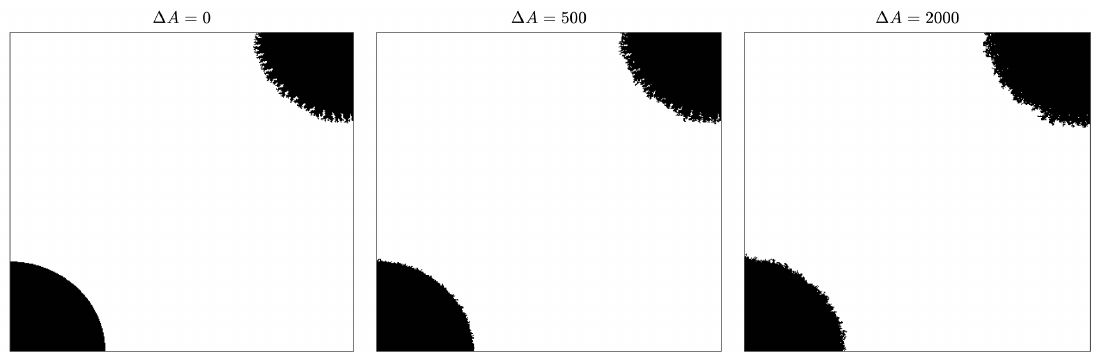
Figure 10. Evolution of two nuclei (irregular and regular), initially both with 10,000 occupied cells. The values of the structural parameters taken in the simulation are β = 1, α = 0.5, and r inf = n /8 (with ( 0 ) = 0 for cells with no adjacent occupied cells to prevent the formation of n = 400). We have taken C ij new nuclei.